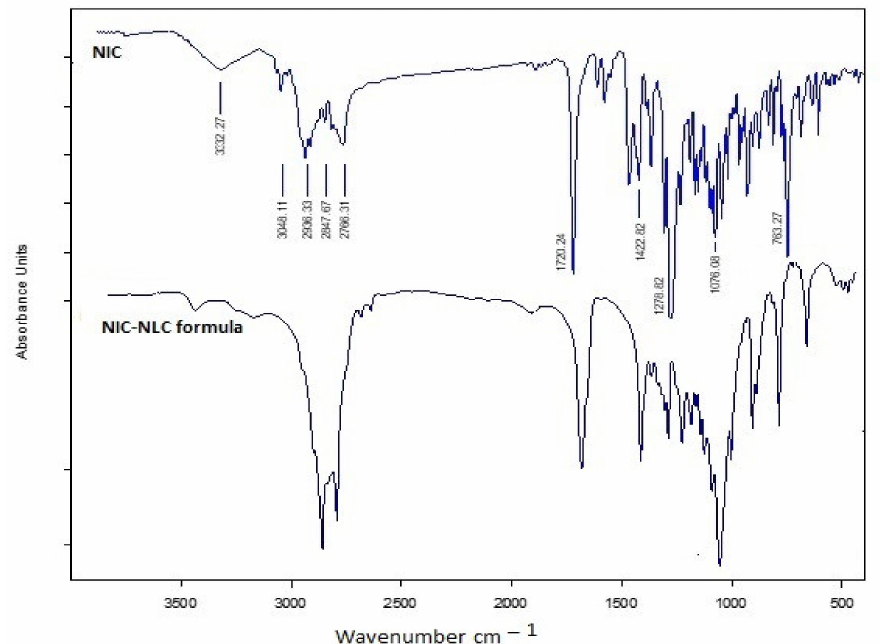
Figure 5. IR Spectra of NIC in comparison to optimized NIC–NLC formula.